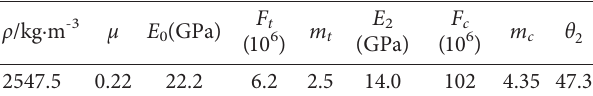
Figure 9: Profile and section of the Gaochou Roadway at the Luling coal mine. Table 2: Mechanical properties of the rock